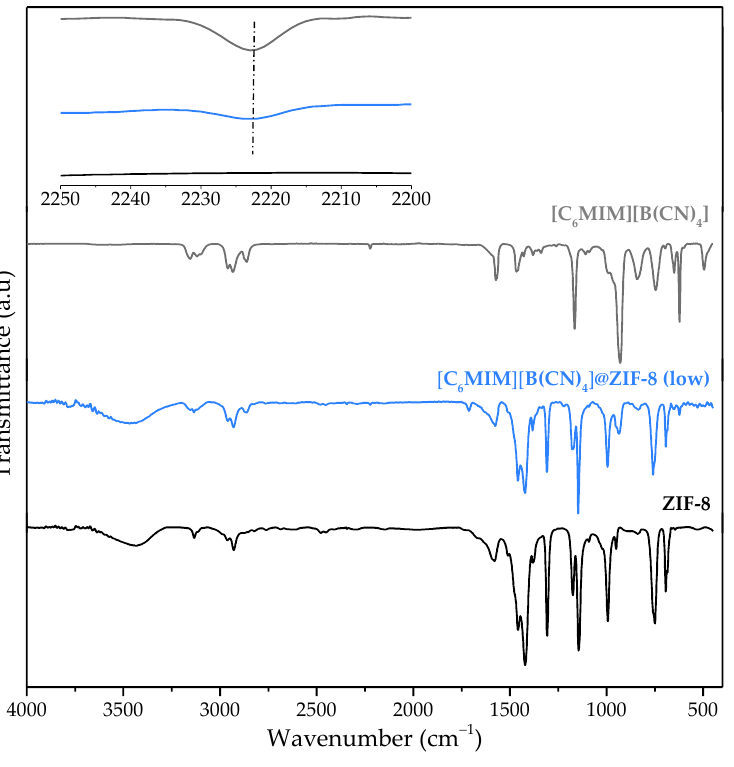
Figure 1. Infrared spectra of neat [C 6 MIM][B(CN) 4 ], [C 6 MIM][B(CN) 4 ]@ZIF-8 (low) and pristine ZIF-8 (the inset details the spectra between 2250 and 2200 cm −1 ).